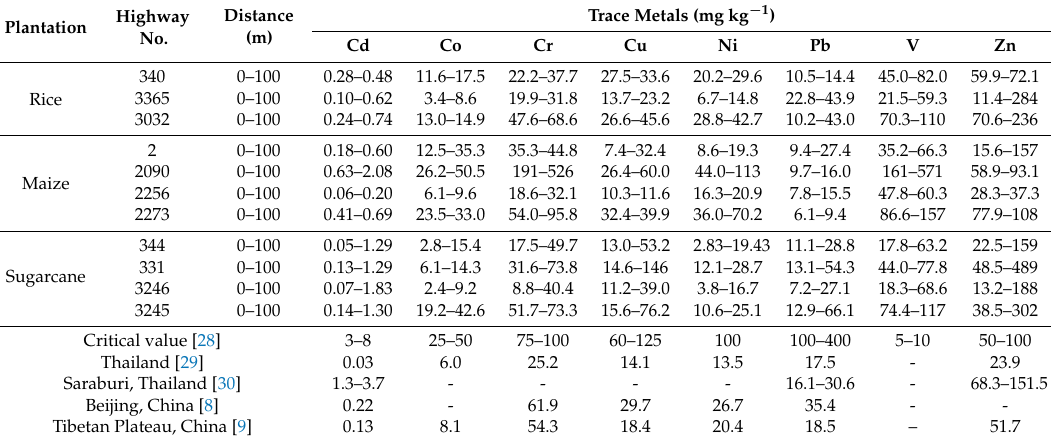
Table 1. Range values of total concentrations of trace metals in roadside agricultural soils at varying